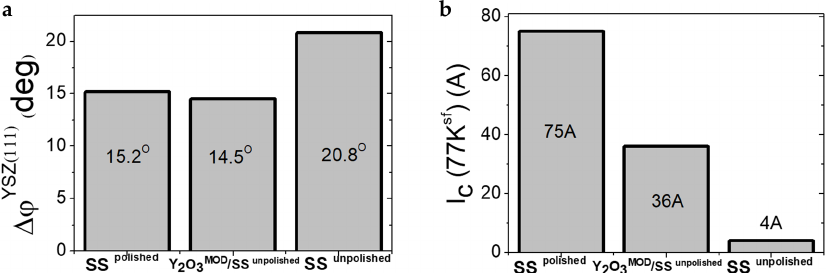
Figure 11. Comparison of texture and superconducting properties between the SS polished , the SS unpolished and the SS/SDP ‐ Y 2 O 3CSD /YSZ ABAD /CeO 2PLD /YBCO PLD stack. ( a ) ϕ scan representing the texture measurements of the SS polished , the SS unpolished and the SS/SDP ‐ Y 2 O 3CSD /YSZ ABAD sandwich architecture; ( b ) Critical current intensity ( I c ) measurements of the different type of substrates in comparison to the SDP ‐ Y 2 O 3 planarization film.